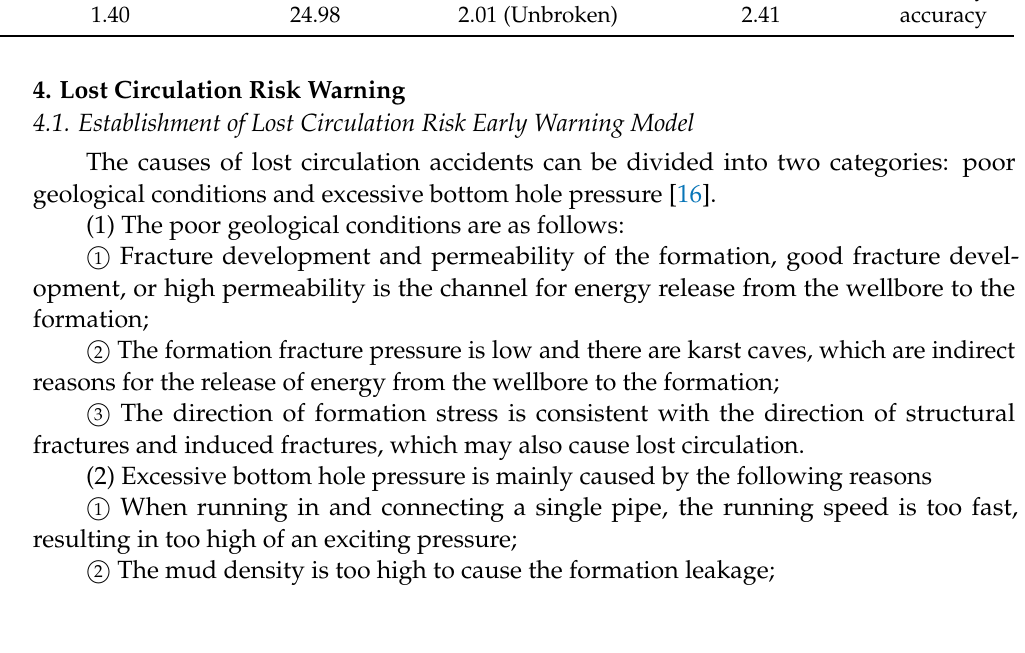
Table 2. Comparison table of formation fracture pressure prediction results and actual drilling data of Yuanba 12 well.